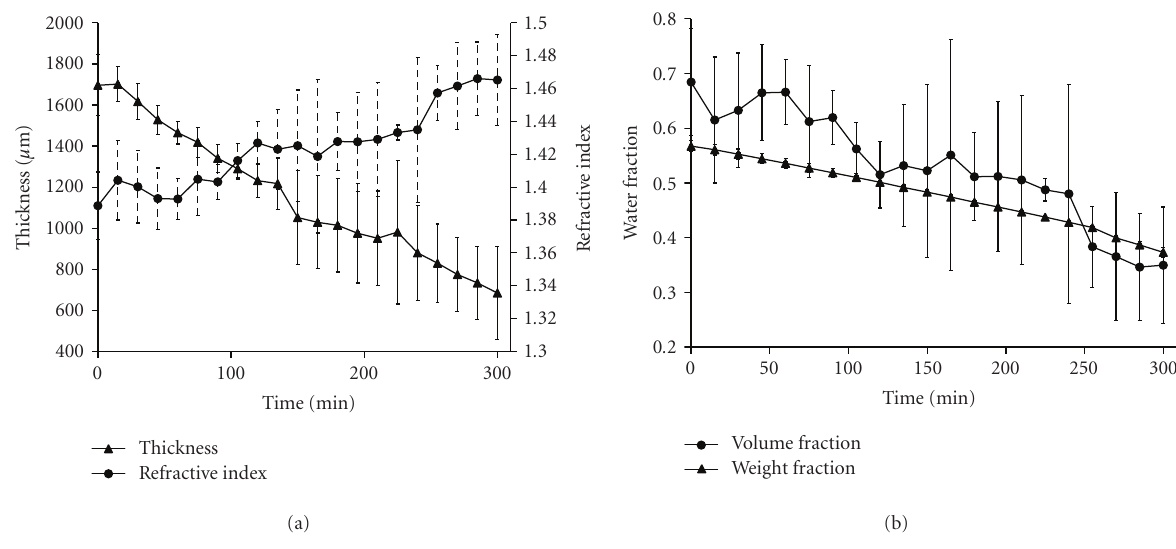
Figure 3: (a) Ex vivo porcine skinsample thickness and refractive index during air immersion.(b) Ex vivo porcine skinwater volume fraction calculated from OCT data and Lorentz-Lorenz equation (circles), and skin water weight fraction calculated from weight loss measurements (triangles) during air immersion. Error bars denote 1 standard deviation.